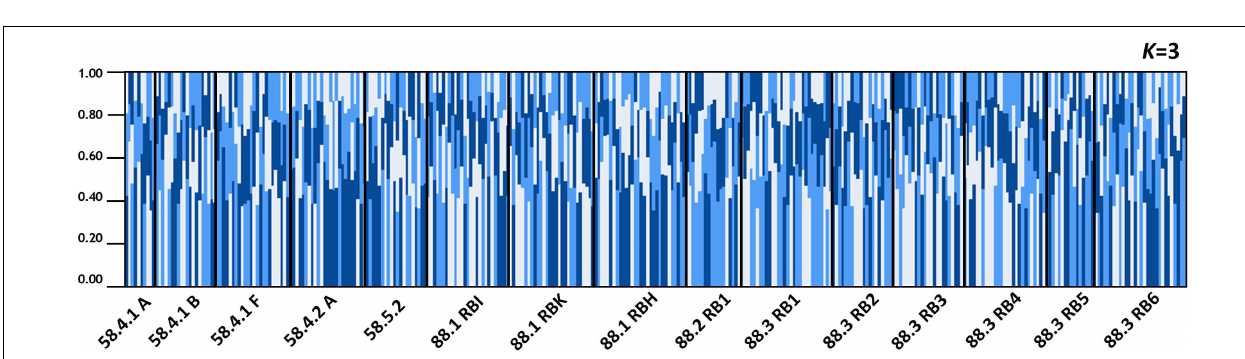
COI (685 bp) is 0.00016 ± 0.00029, which is even